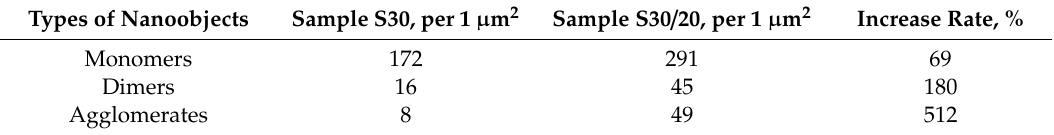
Table 1. Statistical data obtained from the SEM images Figure